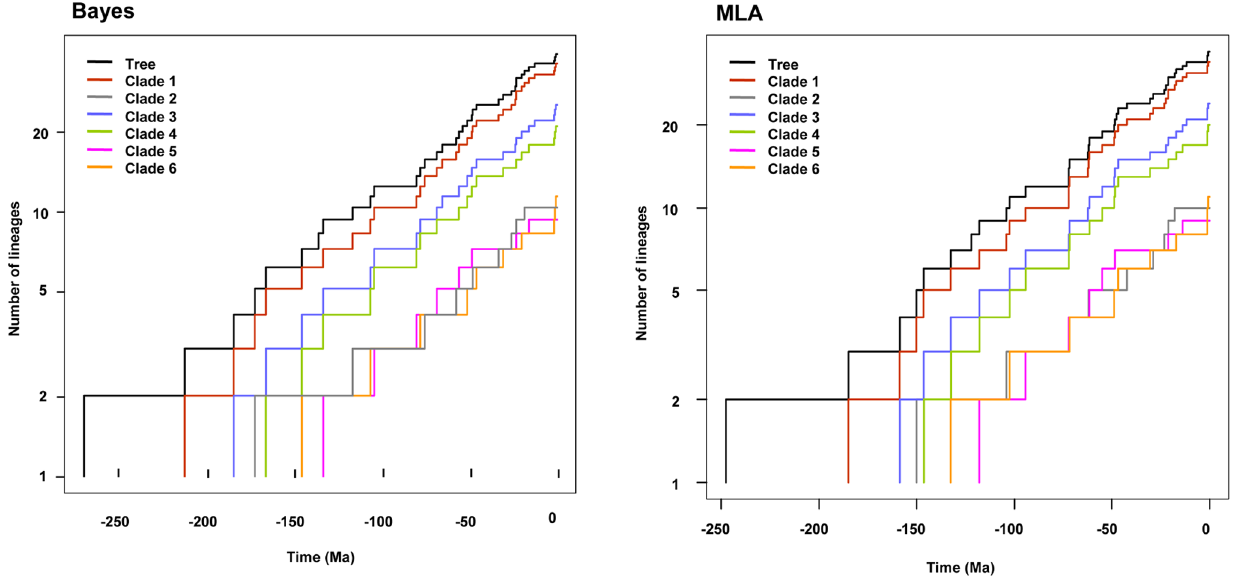
Figure 6. LTT plots for the major clades of Aeromonas . Log-lineage-through-time (LTT) plot for the six major clades inferred by Bayesian (left) and MLA (right) analysis.